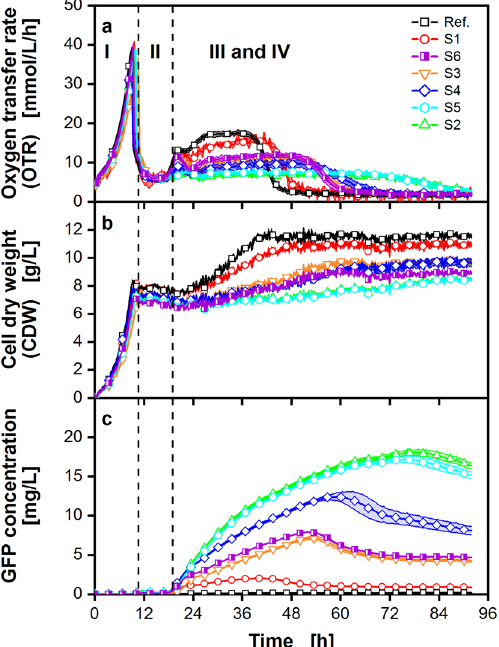
Figure 3. Cultivation of a small clone library of GFP-secreting P. pastoris Mut S strains in a 48-round well microtiter plate with online monitoring of the oxygen transfer rate (OTR), scattered light and GFP fluorescence, measured in a µRAMOS/BioLector combination device 32 . Results are depicted for a cultivation with 10 g/L glycerol and 2% (v/v) of methanol added at the beginning of the cultivation, to obtain auto-induction conditions. ( a ) OTR course for 6 GFP-secreting strains and a no GFP-producing reference strain. For clarity, only every 12th data point is displayed. ( b ) Biomass by backscatter (I-I0) (every 20th data point displayed), ( c ) GFP fluorescence (every 20th data point displayed). The three cultivation phases (I-III) are identified by the OTR curves and are separated by vertical black dashed lines (see Fig. 1). Cells with an initial optical density (OD Each cultivation was performed in triplicates. Light shadow depicts the standard deviation. In some cases, the standard deviation is so small that the error is not